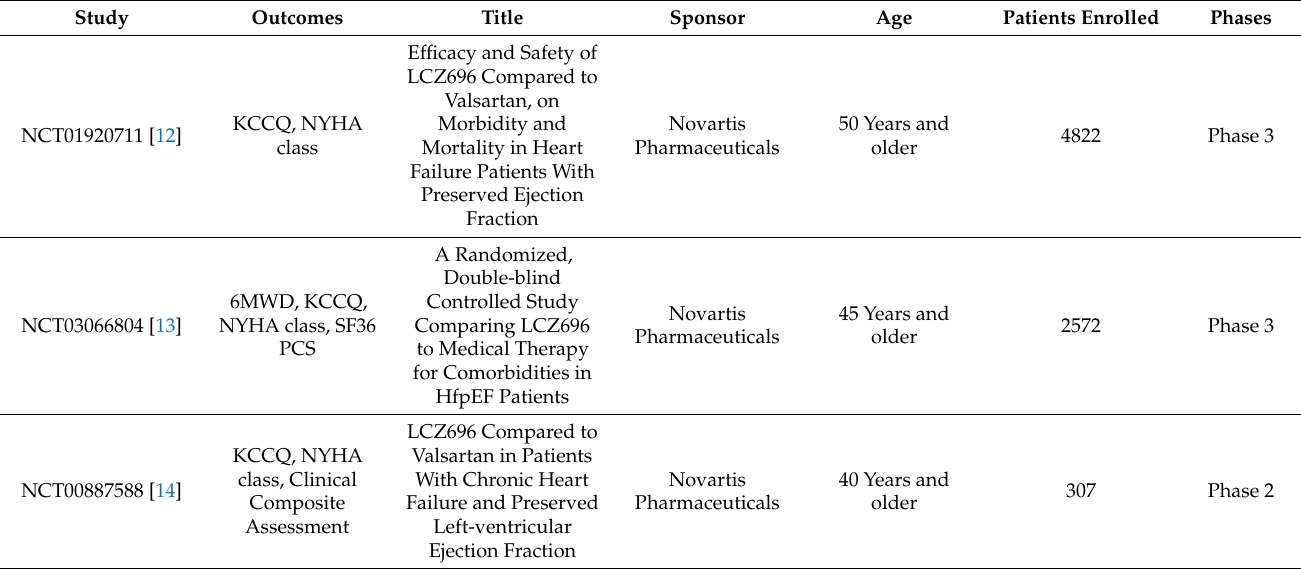
Table 2. The study